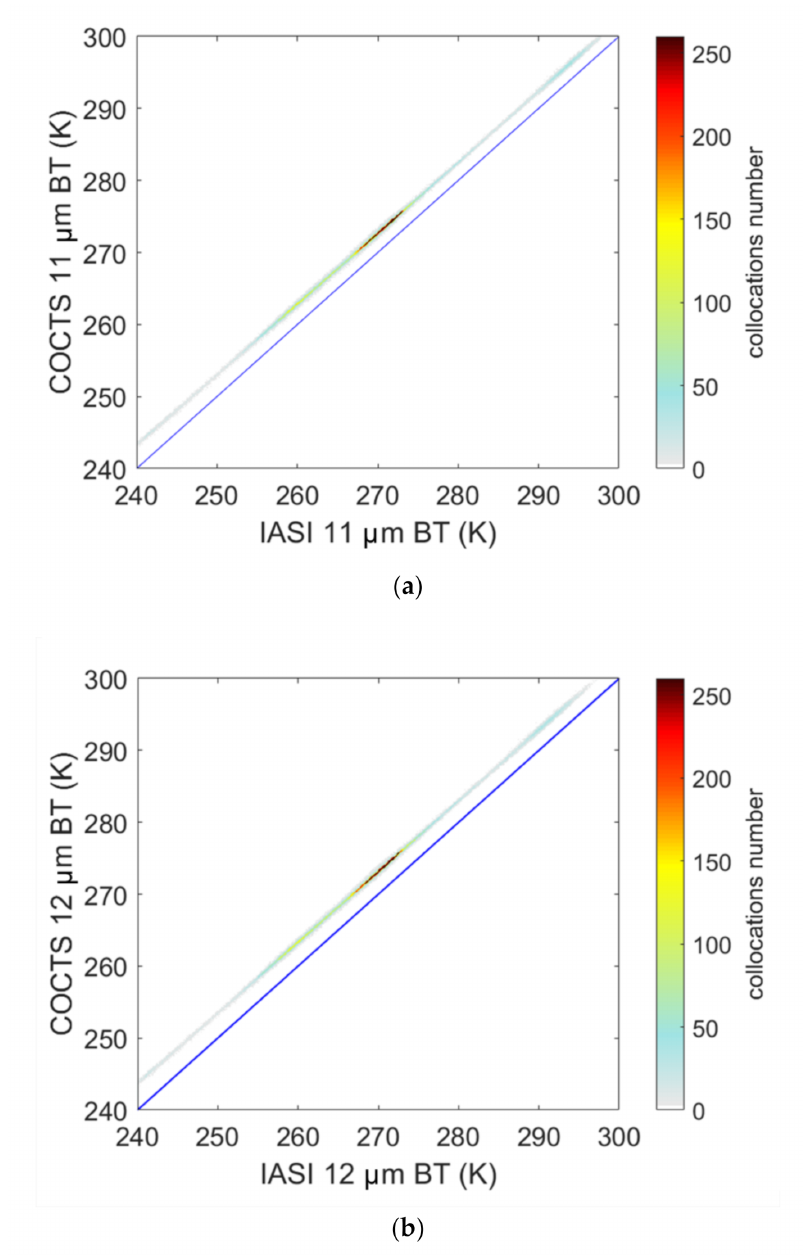
Figure 5. The scatter diagrams of the HY-1C COCTS and IASI BTs for the ( a ) 11 and ( b ) 12 µ m channel. The colored points show the collocated BT values of COCTS and IASI measurements. The blue lines represent the situation where COCTS BTs are equal to IASI